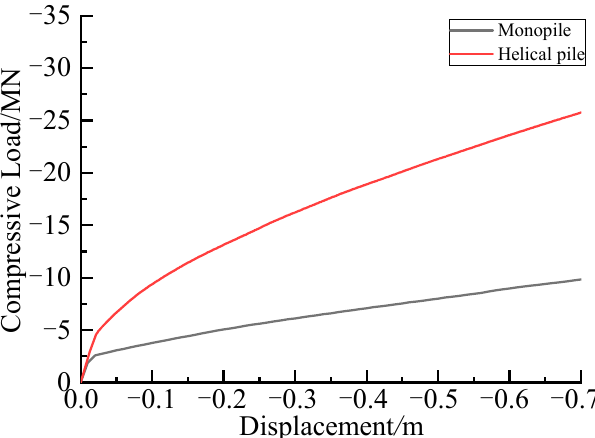
Figure 5. Compressive load-displacement curve.